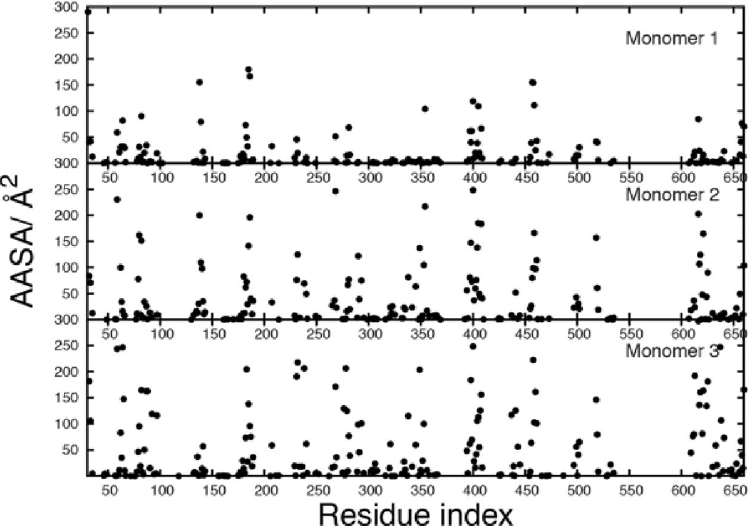
Figure 5. Average antibody accessible surface area (AASA), Å 2 , of the protein residues from the three monomers. Results are the average over the HREST-BP Env simulation sampled every 0.08 ns with AASA values calculated using a probe radius of 10 Å and an accuracy of 0.5. Values are presented for those residues with an average AASA of greater than 0.1 Å 2